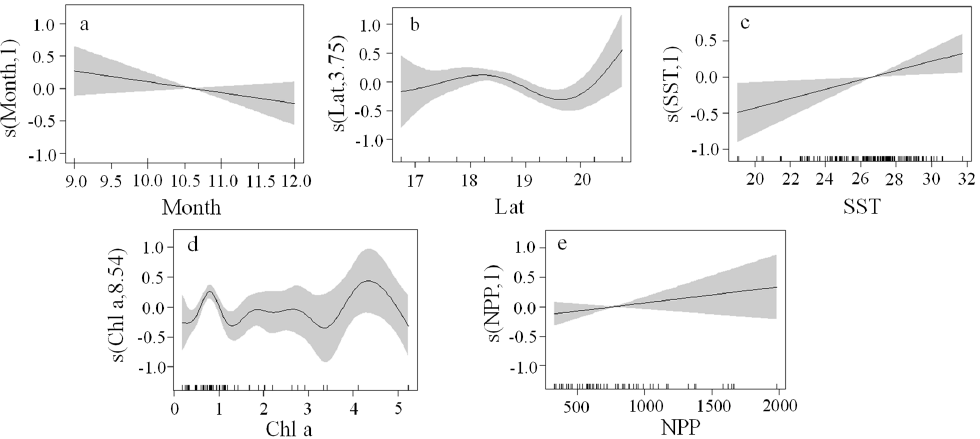
Figure 3. GAM analysis of the effects of the spatiotemporal and environmental factors on CPUE in the Beibu Gulf: ( a ) month, ( b ) latitude (lat), ( c ) SST, ( d ) chlorophyll a concentration (Chl a) and ( e ) NPP. Shadow areas, 95% confidence intervals. Rug plots on the x-axis, relative density of data points.